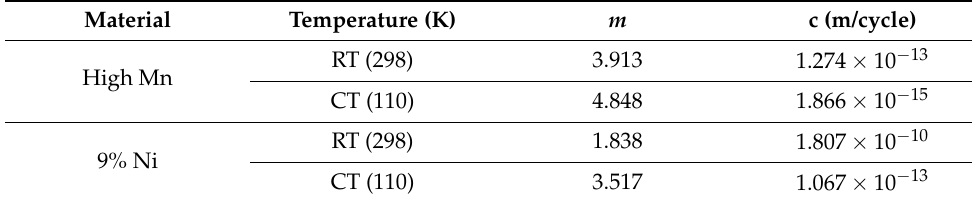
Table 7. FCGR test results of weld metals.